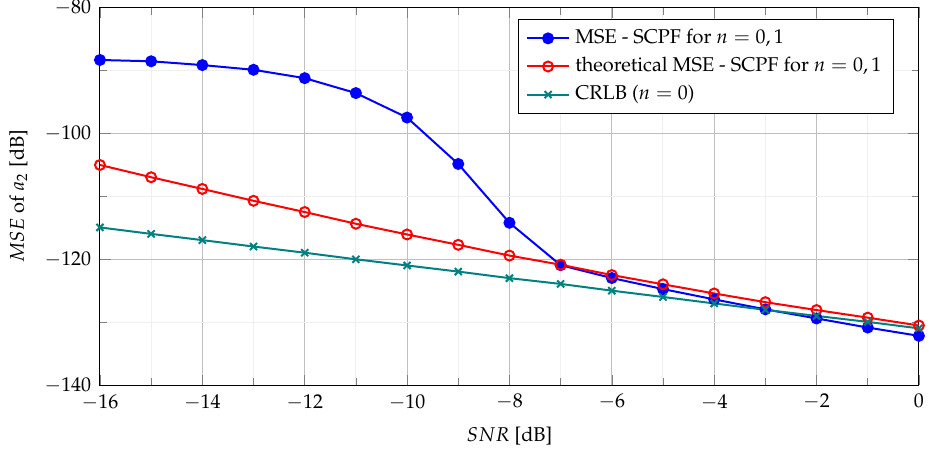
0,1 0,1 . Figure 11. Theoretical and measured MSEs of the SCPF for n = { } { }